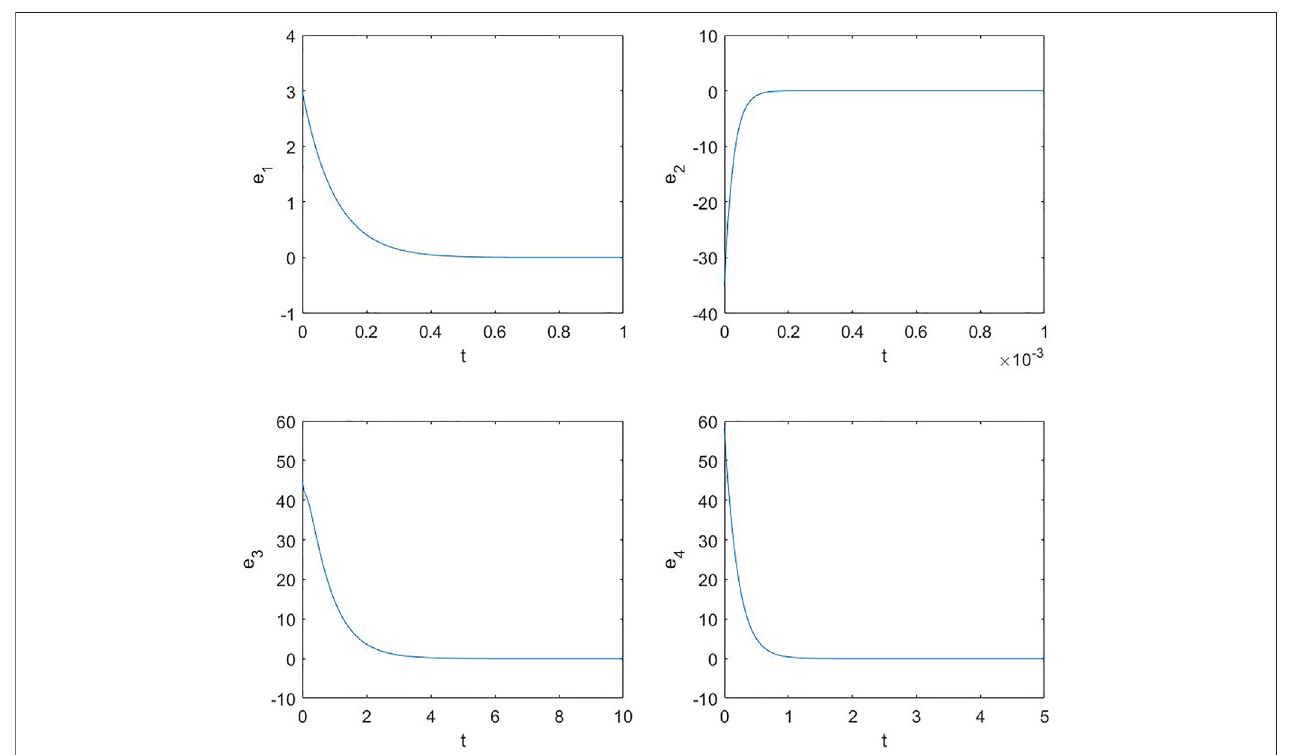
FIGURE 3 | Error synchronization by the control law ( Eq. 11 ) associated with ( Eqs 12 , 13 ).